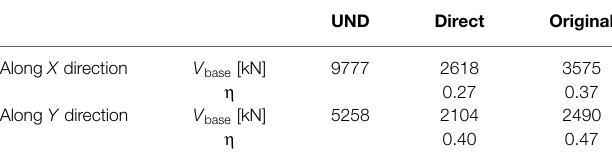
TABLE 9 | Reduction in the base shear (original vs. direct five-step proce- dure)